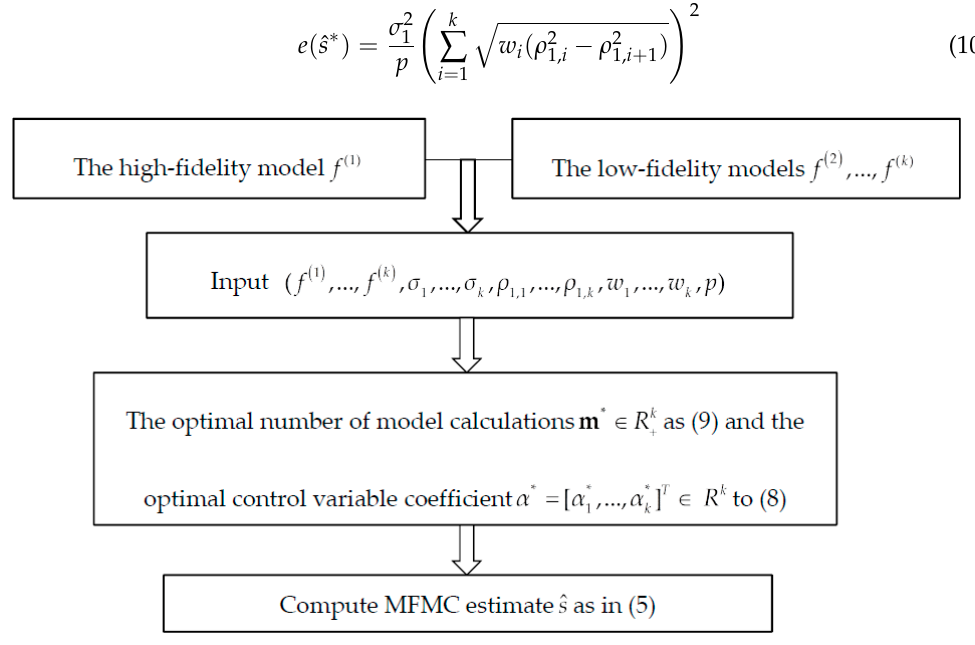
Figure 1. The MFMC framework.